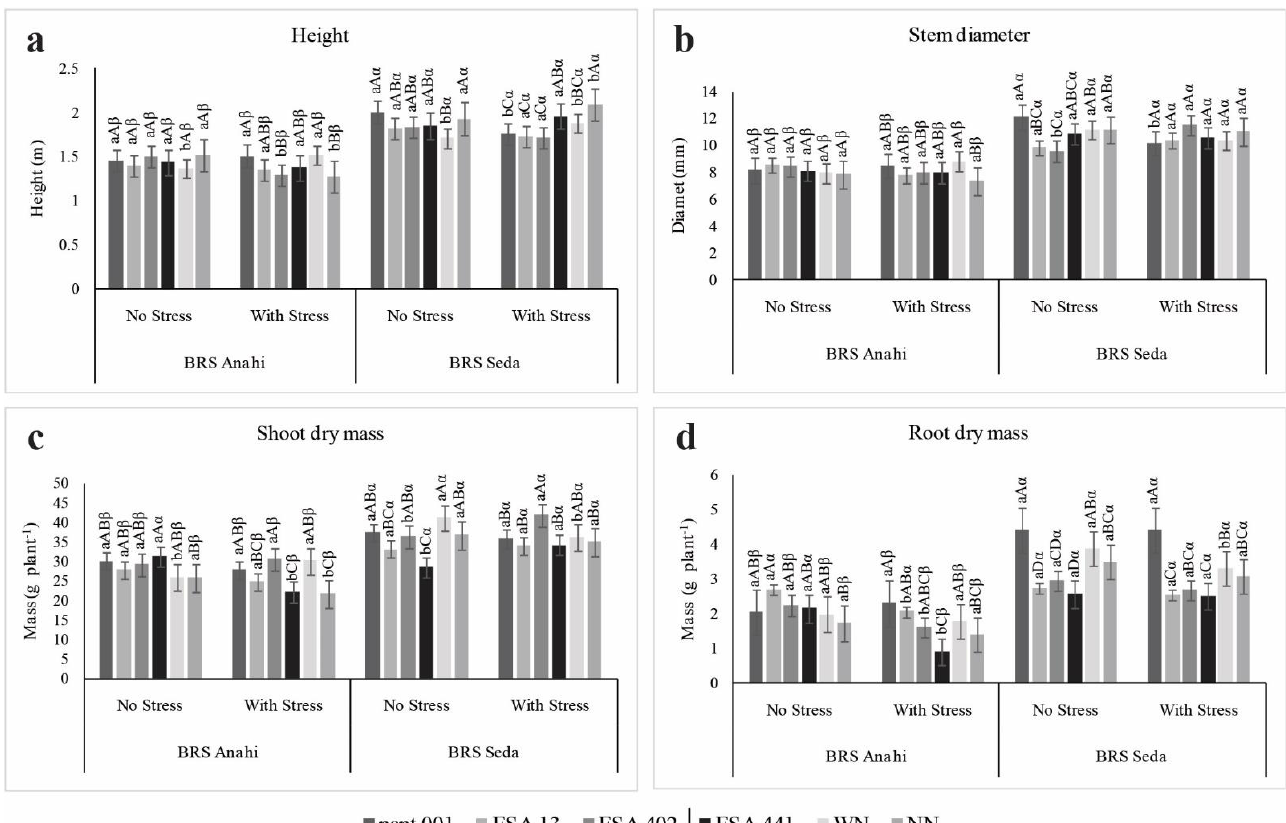
Figure 4. Growth characteristics of sesame cultivars (BRS Anahí and BRS Seda) inoculated with bacilli, under water deficit and different nitrogen sources. WN-with nitrogen and NN-no nitrogen. Plant height ( a ), stem diameter ( b ), shoot dry mass ( c ) and root dry mass ( d ). Lowercase letters compare the water regime within each cultivar; capital letters compare treatments within each cultivar; Greek letters compare cultivars.